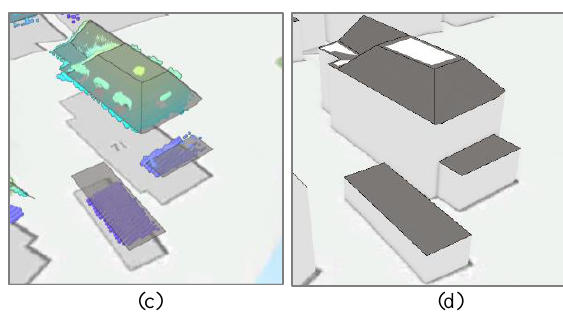
Figure 7. Point to point distance calculation in x (a and b), y (c and d) and z (e and f)